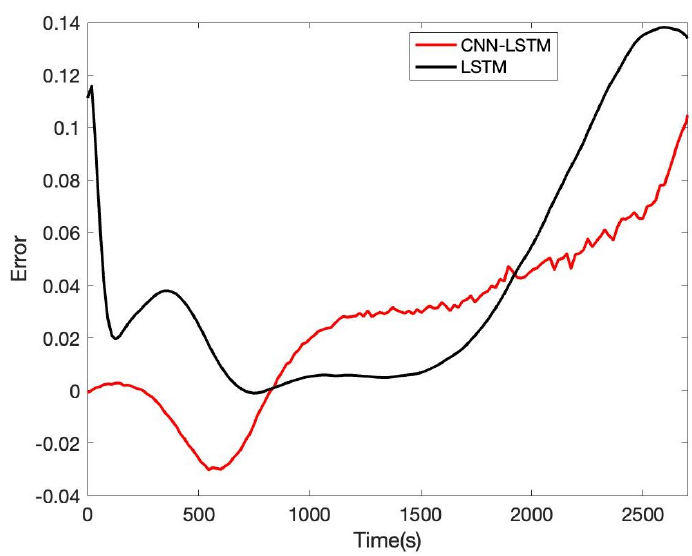
Figure 18. Battery SOE prediction error of